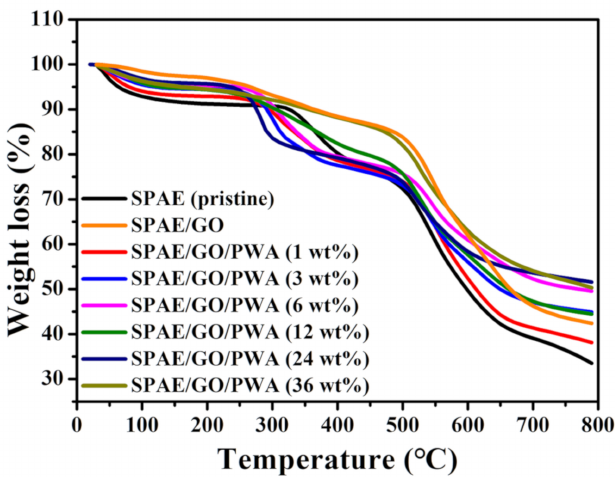
Figure 4. TGA in a nitrogen atmosphere of sulfonated poly(arylene ether) composite